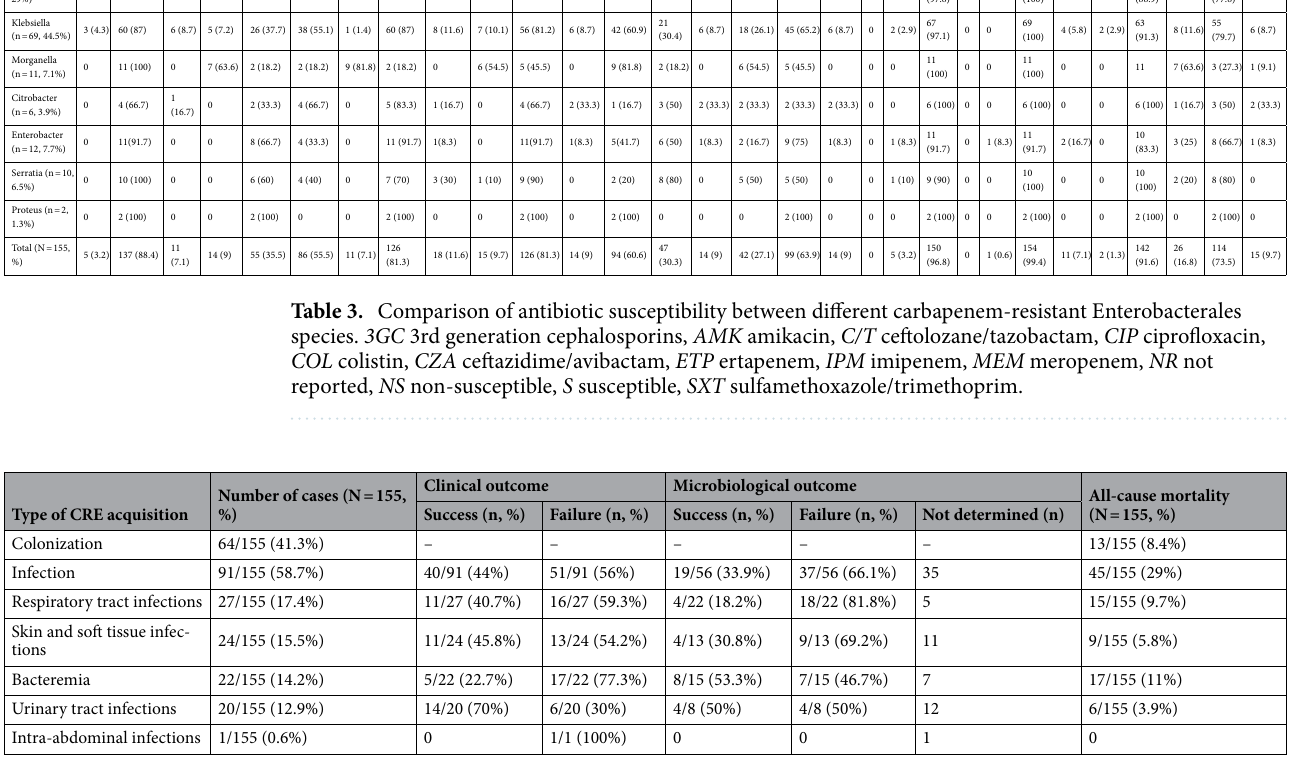
Table 4. Patient outcome and all-cause mortality stratified according to the type of infection caused by carbapenem-resistant Enterobacterales. For each type of infection: Clinical success (%) = ( Number of patients with clinical success /Total number of patients) × 100. Clinical failure (%) = ( Number of patients with clinical failure /Total number of patients) × 100. Microbiological success (%) = Number of patients with microbiological success/( Total number of patients − Number of patients with undetermined microbiological response )] × 100. Microbiological failure (%) = Number of patients with microbiological failure/( Total number of patients − Number of patients with undetermined microbiological response )] × 100.